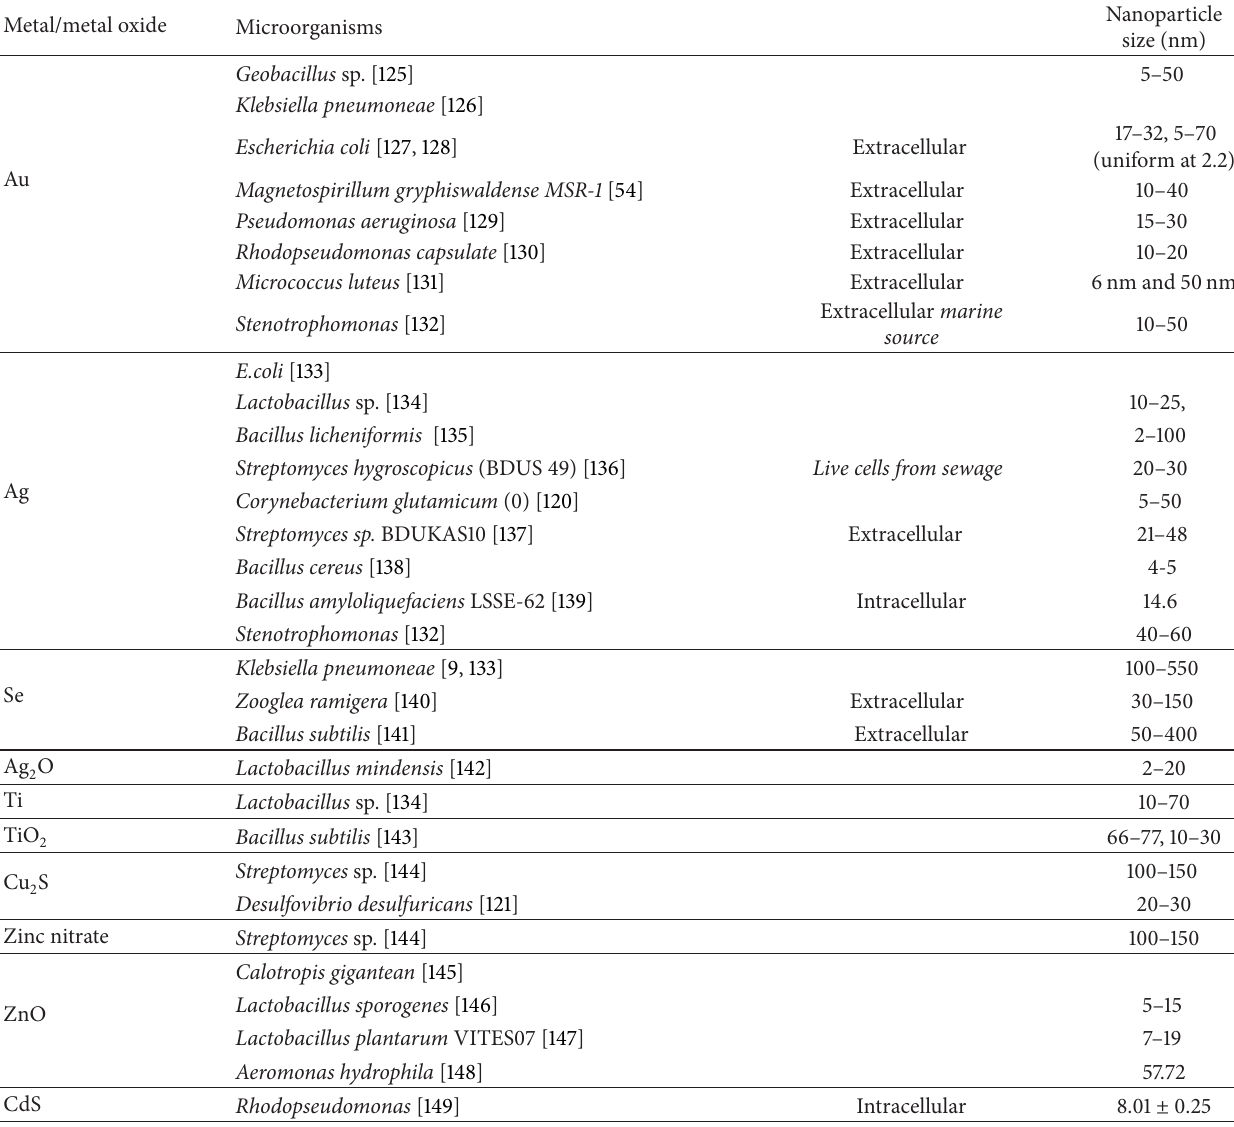
Table 3: Bacteria-mediated biosynthesis of